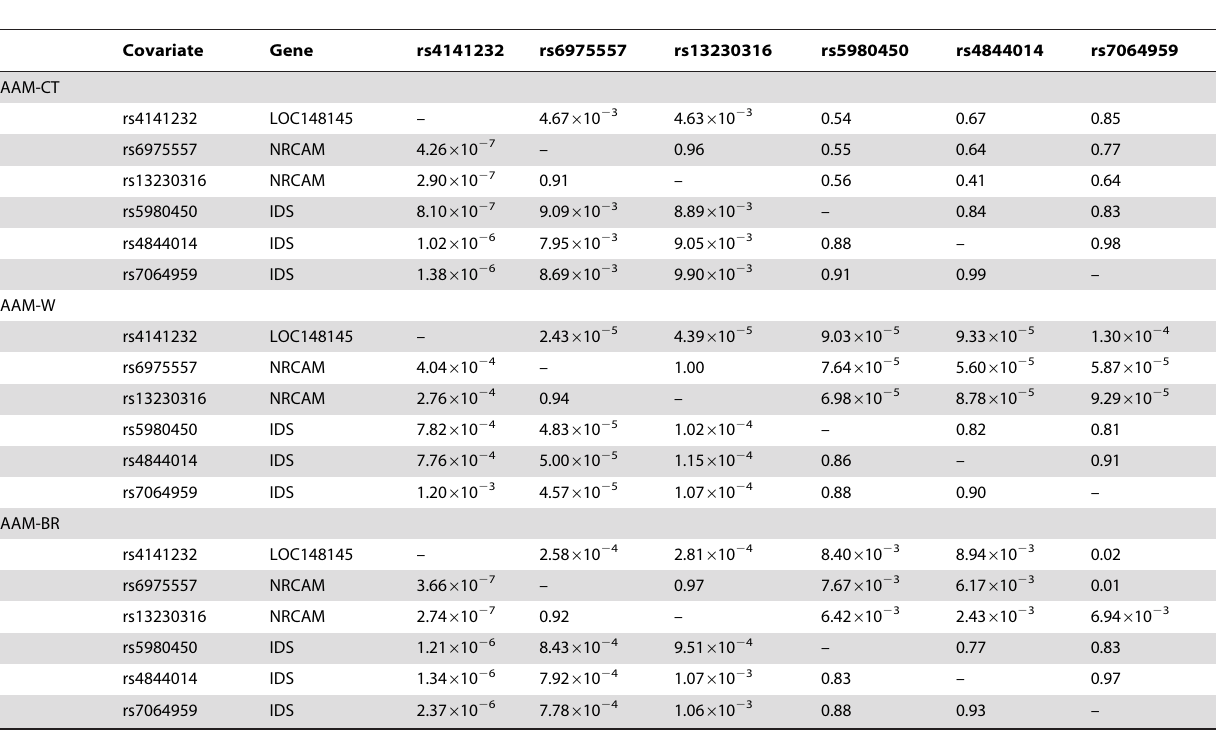
Table 7. The causal relationship of the six SNPs for three trait pairs in the discovery sample.